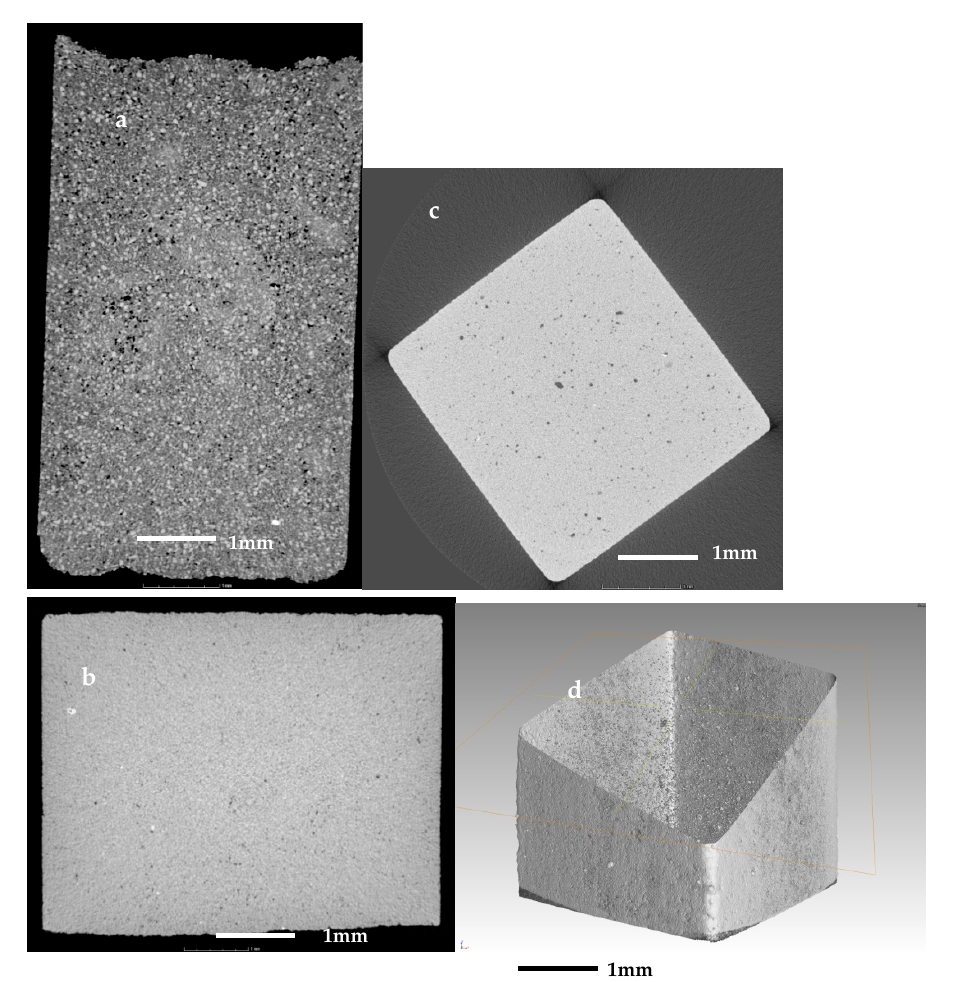
Figure 7. Photographs of the studied materials: ( a ) Press-powder; ( b ) Sintered glass-ceramics syn- thesized at 900 °C; ( c ) Self-glazed glass-ceramics obtained at 1020 °C; ( d ) Glass-ceramic foam sam- ple bloated at 1100 °C.